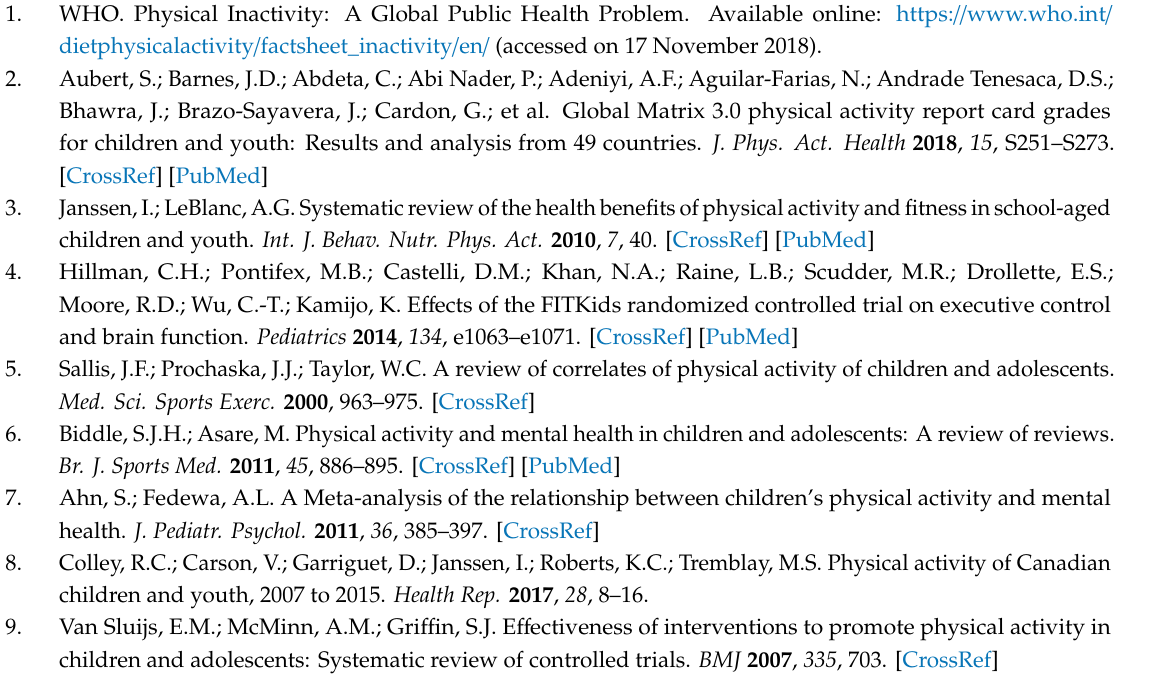
Table S5: Individual-level correlates of children’s independent mobility using complete cases. Table S6: Social-environment-level correlates of children’s independent mobility using complete